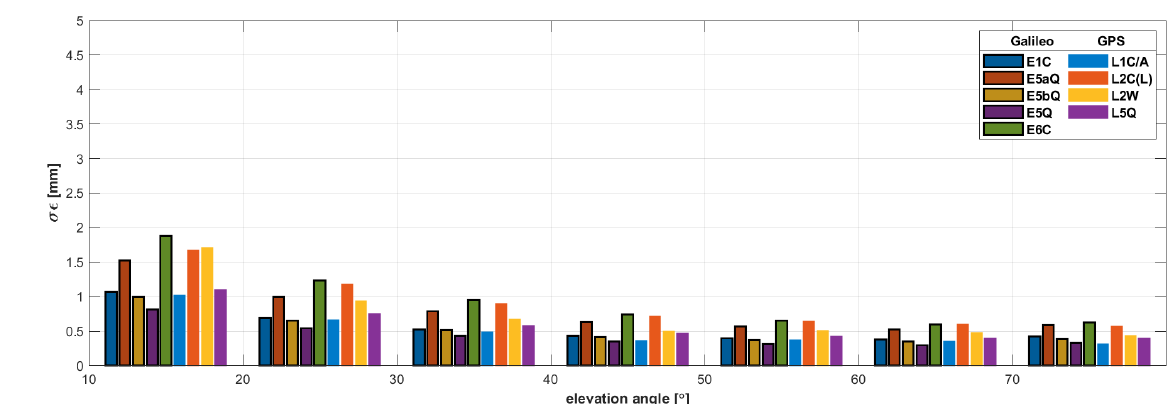
Figure 6. Standard deviation of phase multipath error versus elevation.